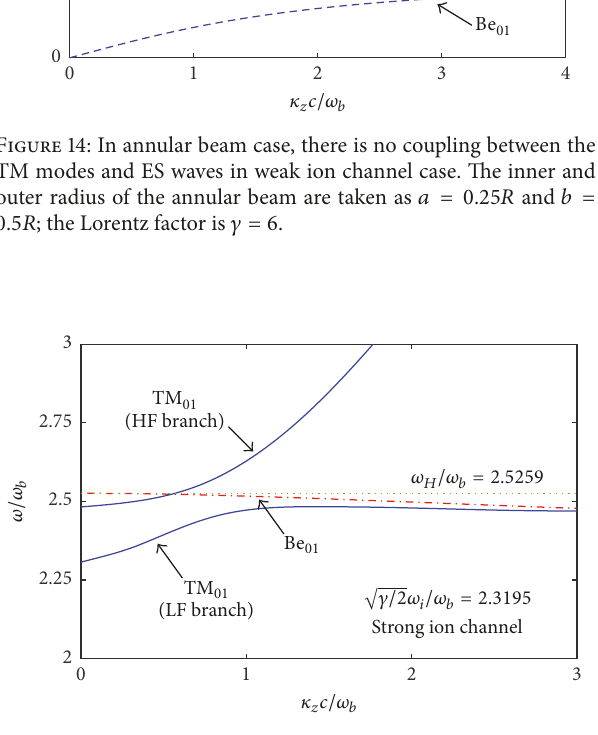
Figure 15: In annular beam case, the TM wave of the two branches can interact with the betatron wave in strong ion channel case. The inner and outer radius of the annular beam are taken as 𝑎 = 0.25𝑅 and 𝑏 = 0.5𝑅 ; the Lorentz factor is 𝛾 = 6 .